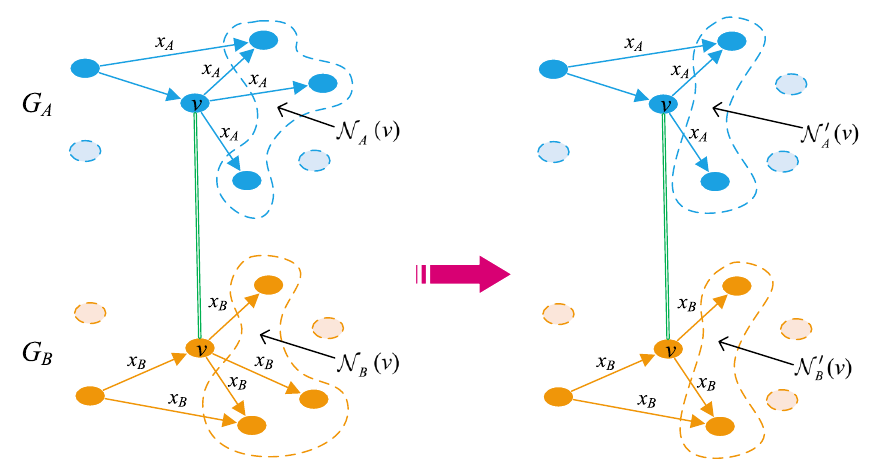
V j , E j (cid:31) (cid:30) denote the connected forwarding graph of the j th SCP y j , where V j is the set of nodes that has received